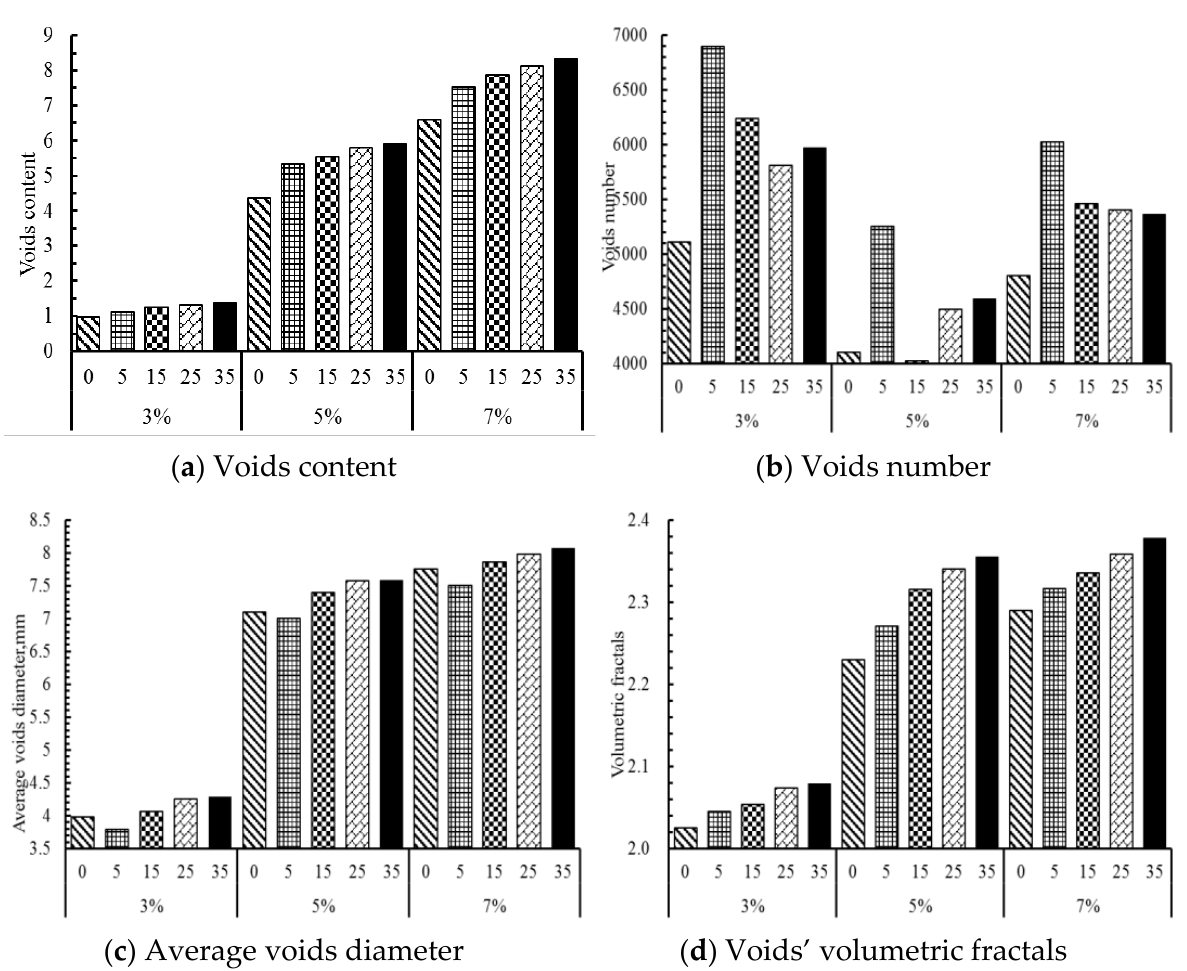
Figure 7. Effect of design void content on internal structure evolution during freeze–thaw cycles. Figure 7c shows the changes of average 3D void diameter in asphalt mixtures with three types of design void content, compared before and after freeze–thaw cycles. Average air void diameter abruptly decreases at the initial stages of the test, but gradually increases during the subsequent freeze–thaw cycles regardless of the design void content. As shown in Equation (2), the change of average air void diameter is affected by the variation of void content and void number. Corresponding to the variation in void content, void number, and void volume grades during freeze–thaw cycles, the reduced void diameters in asphalt mixtures at initial stages are caused by increasing number of voids with a volume less than 0.1 mm 3 . This demonstrates that it is the newly formed voids that greatly influence the void diameter during freeze–thaw cycles. Moreover, the average void diameter was observed to increase after the fifth freeze–thaw cycle. This result indicates that existing air voids coalesce and air void volume increases with increasing number of freeze–thaw cycles. Comparing Figure 7a,d, variations of air void content and void volumetric fractals with increasing number of freeze–thaw cycles are investigated. A strong correlation between the air void content and void volumetric fractals in the hot mix asphalt mixture is observed. According to the definition of void volumetric fractals, if the value is closer to 2, its shape approximates a sphere in 3D space. Considering both Figure 7d and Table 4, void volumetric fractals of the sample with design void content of 3% are close to 2, and the majority of air voids’ volume is less than 1 mm 3 . This demonstrates that void volumetric fractals are related to single void volumes during sample preparation, i.e., the smaller the void volume is, the higher similarity the shape possesses to a sphere. As the air